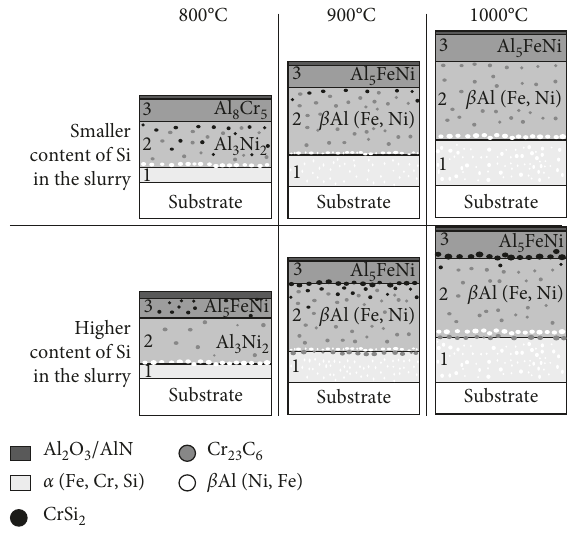
Figure 10: XRD patterns (the coating number 7 obtained at 800 ° C, 10 hours, Al/Si (cid:31)